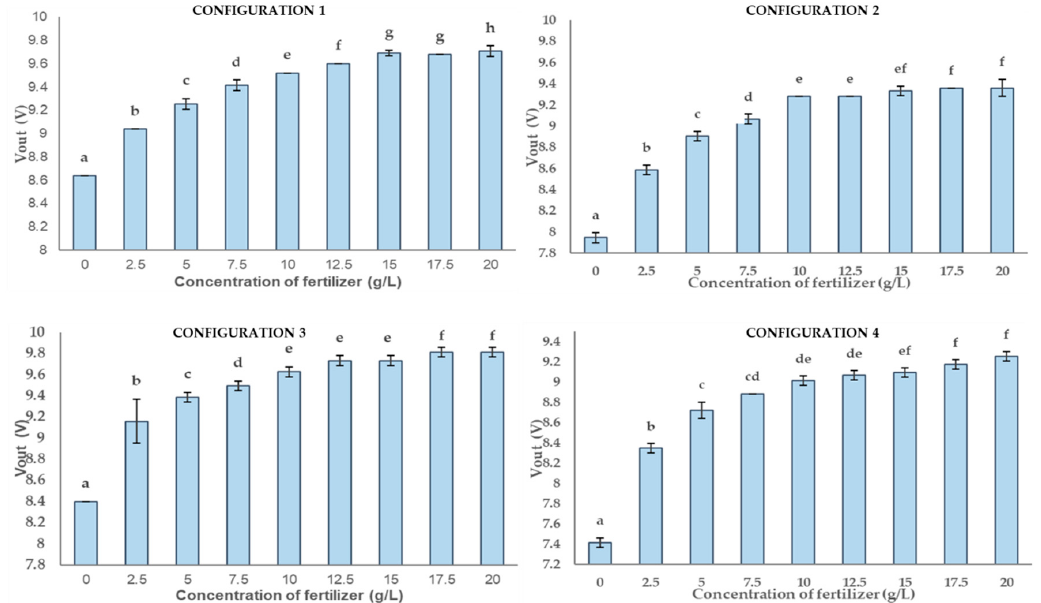
Figure 14. The graph presents a multi-range analysis for the four configurations where they are drawn by columns. Each column contains non-significant values between them. The different letters show that the values are statistically significant. In each column, the vertical bar on it represents the